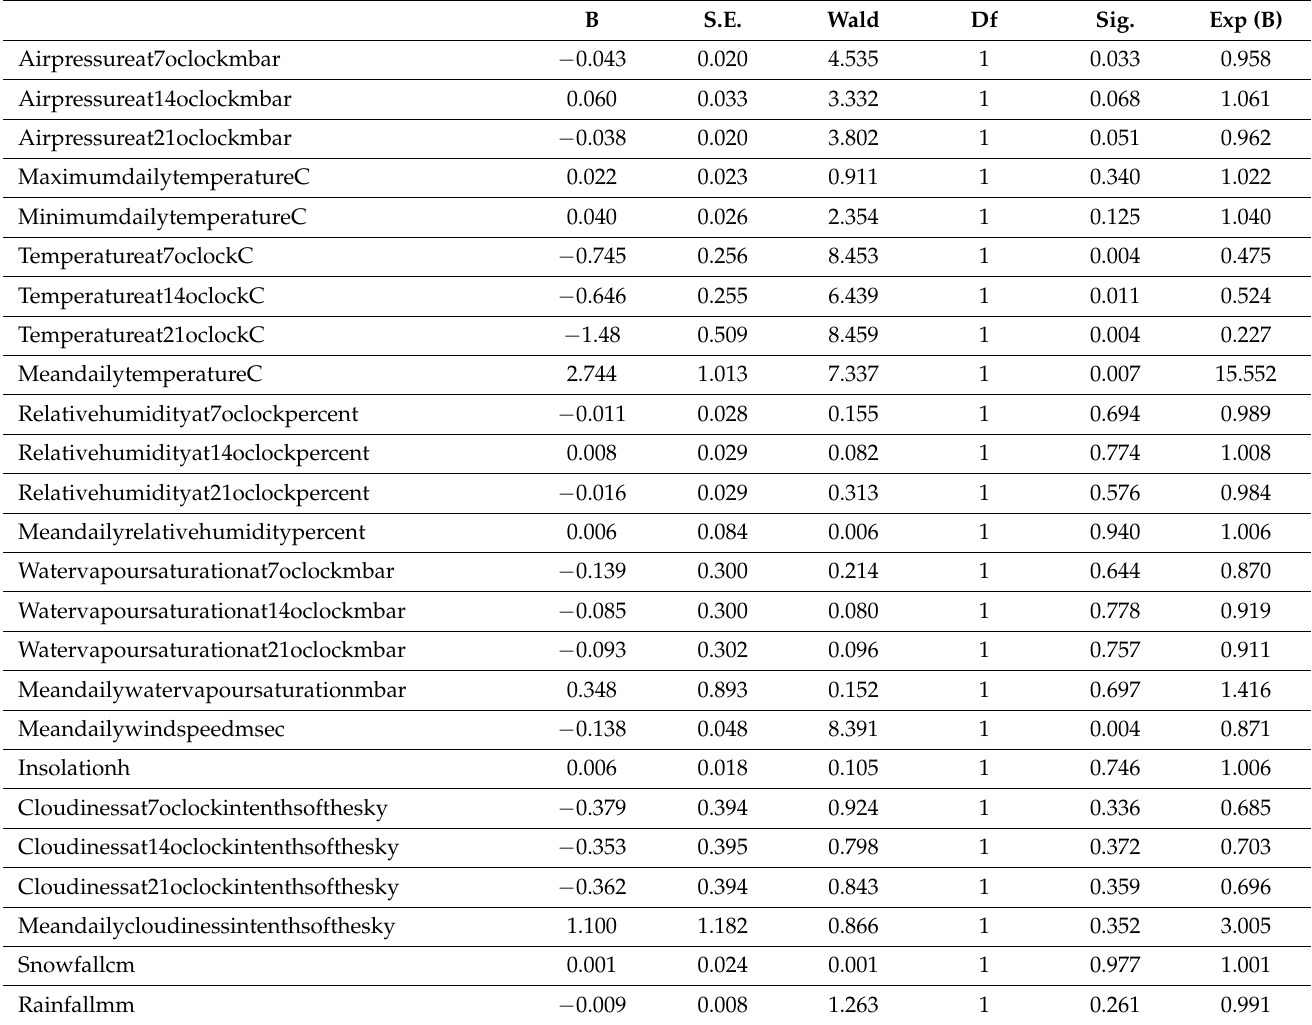
Table 3. Results of applied binary regression—all 27